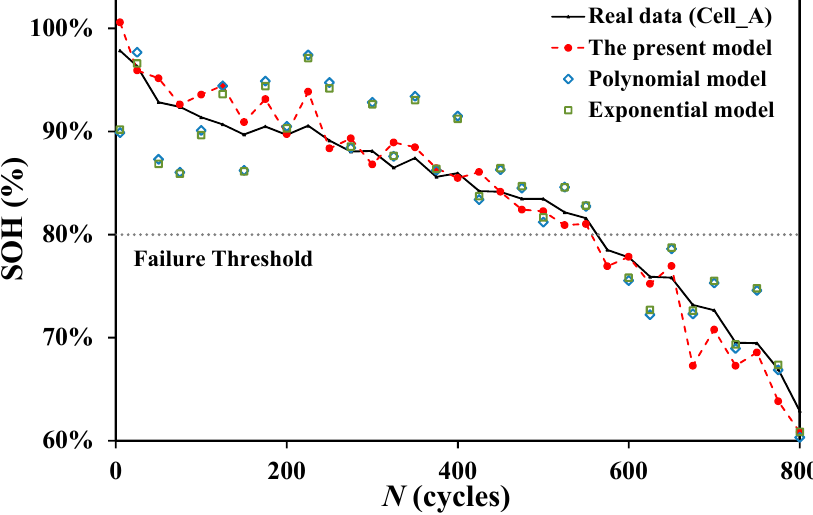
Figure 11. Comparisons of the present and two existing